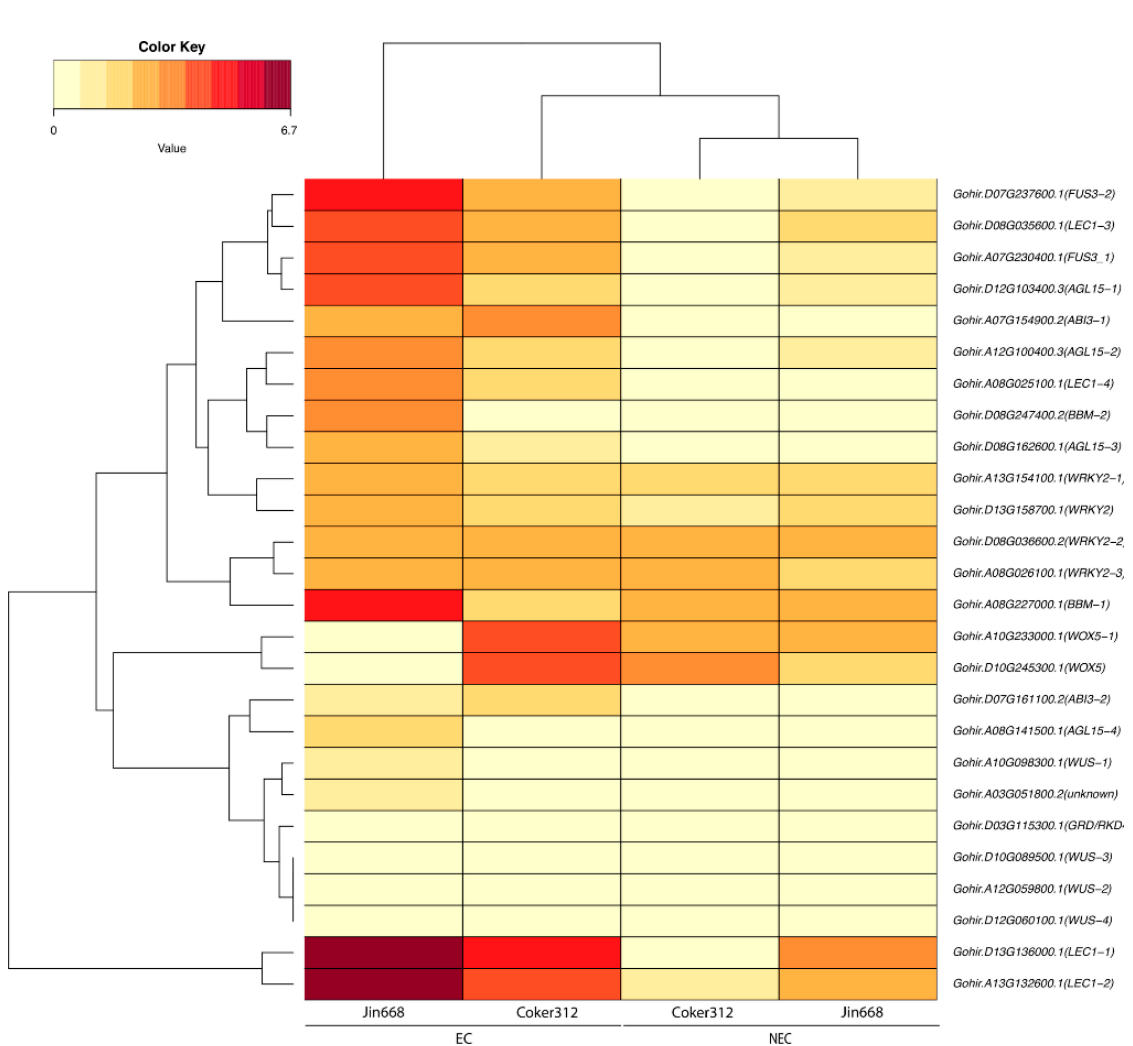
Figure 5. Heatmap representing the gene expression of key embryogenic genes of Coker312 and Jin668 in the NEC and EC callus